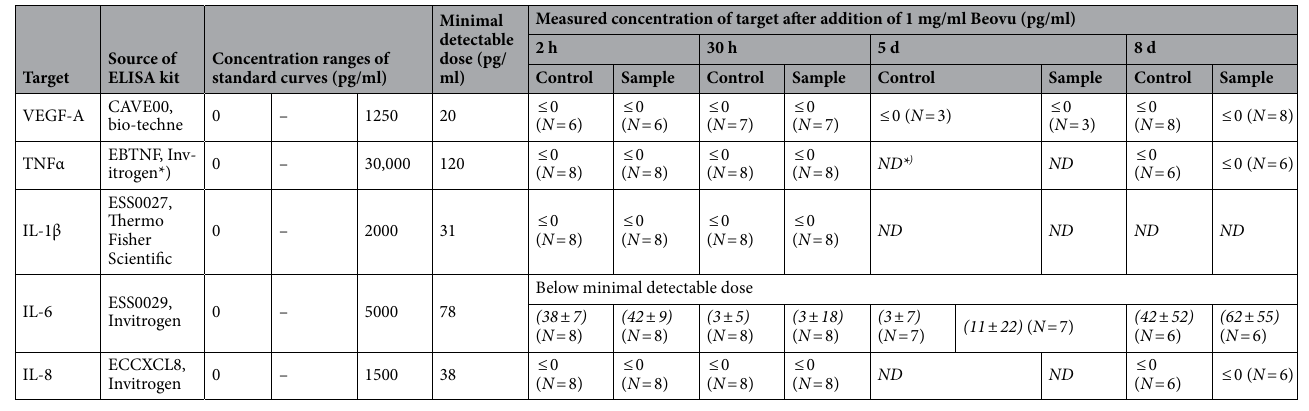
Table 1. Measured cytokine concentrations in cell culture supernatants. *Bio-techne: Wiesbaden, Germany; Invitrogen via Thermo Fisher Scientific: Schwerte, Germany; ND: not done; means ± standard deviations are